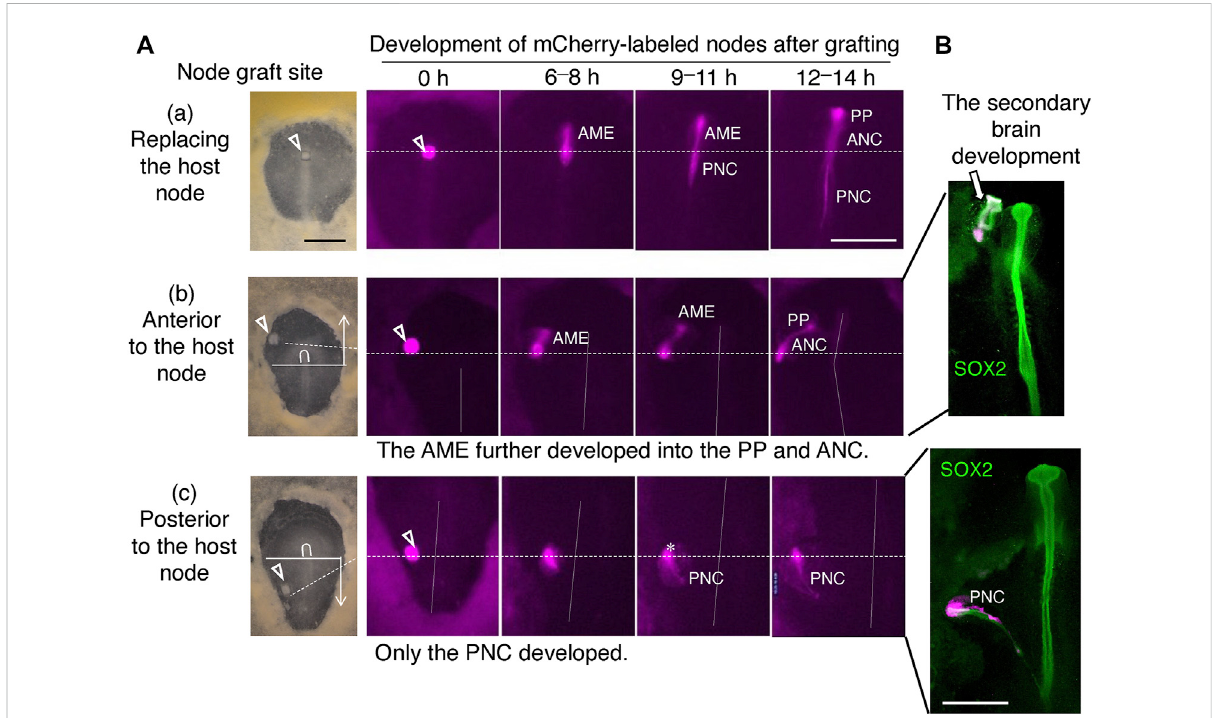
FIGURE 4 The developmental outcome of the node graft labeled with mCherry depended on the graft sites. (A) Development of the node grafts from mCherry-expressing st. 4 Japanese quail embryos at various positions of the chicken host embryos: (a) Replacing the host node; (b) Anterior to the host node; (c) Posterior to the host node. Inverted U, host node; horizontal solid lines, the boundary of anterior and posterior embryonic regions; broken horizontal lines, the anteroposterior level of the node grafting; vertical dotted lines, the host embryo axes; scale bar, 500 μ m; AME, anterior mesendoderm; PP, prechordal plate; ANC, anterior notochord; PNC, posterior notochord. (B) Embryos analogous to (b,c) were immunostainedforSOX2.NodegraftingatananteriorpositionalwaysresultedinsecondarybraindevelopmentexpressingSOX2.Scalebar,500 µm. Adapted from Supplementary Figure S7 of Yoshihi et al.